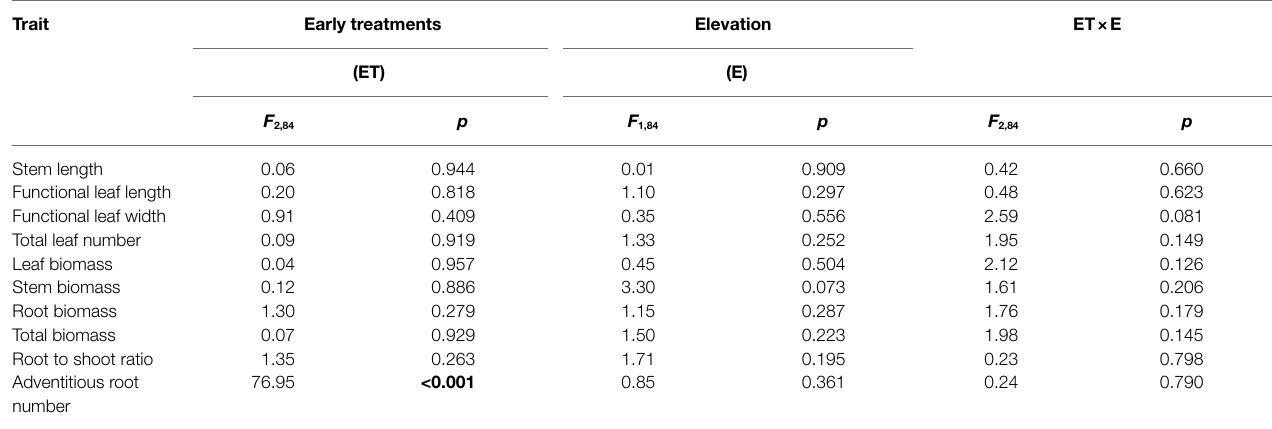
TABLE 1 | ANOVA results for effects of early treatments (ET: early control, early flooding, and early eutrophic flooding) and elevations (E: low and high) on stem length, functional leaf length and width, total leaf number, leaf biomass, stem biomass, root biomass, total biomass, root to shoot ratio, and adventitious root number in Polygonum hydropiper at the end of early treatments.